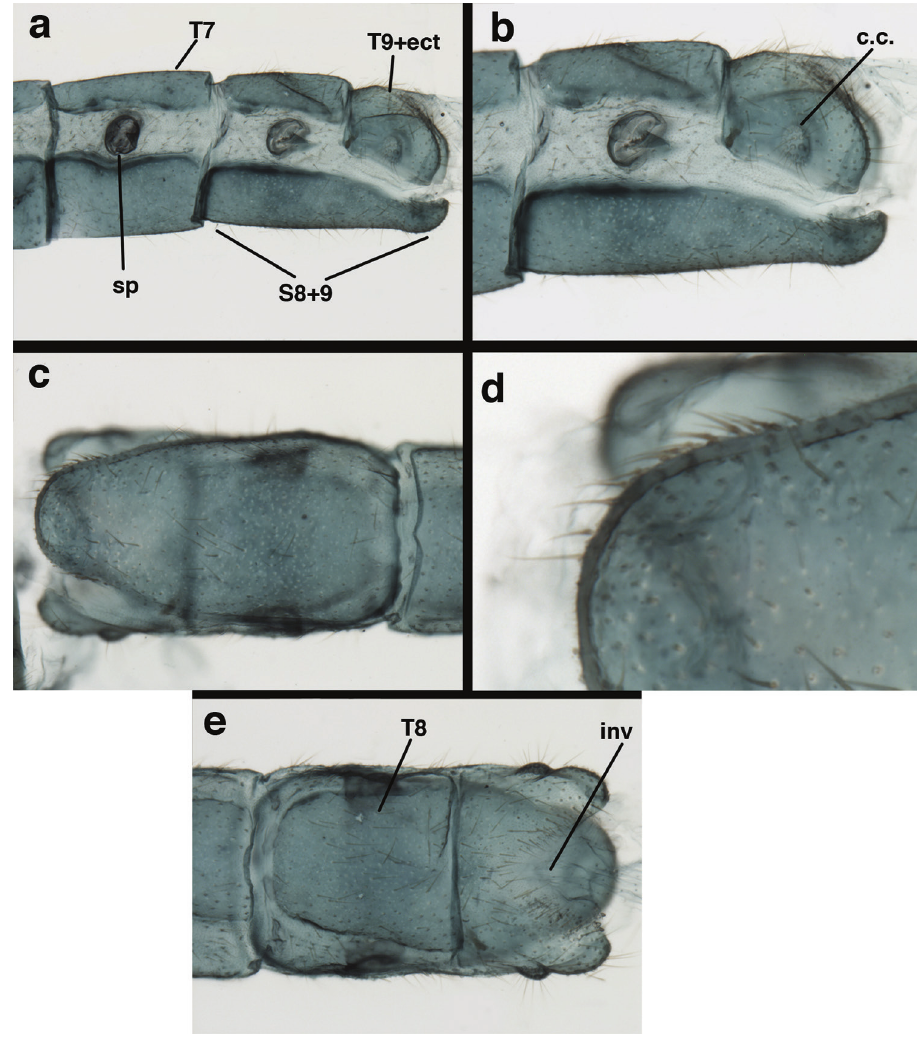
Figure 59. Ungla martinsi Sosa: Male abdomen, ( a ) segments A7-terminus, lateral ( b ) segments A8-ter- minus, lateral ( c ) fused sternites S8+9, ventral ( d ) tip of sternite S9, ventral, with enlarged, flanged setae ( e ) tergites T8 and T9, dorsal. c.c. callus cerci inv invaginated dorsal cleft in T9+ectoproct sp spiracle S8+9 fused eighth and ninth sternites T7, T8 seventh and eighth tergites T9+e ninth tergite + ectoproct (all: Venezuela, Aragua,